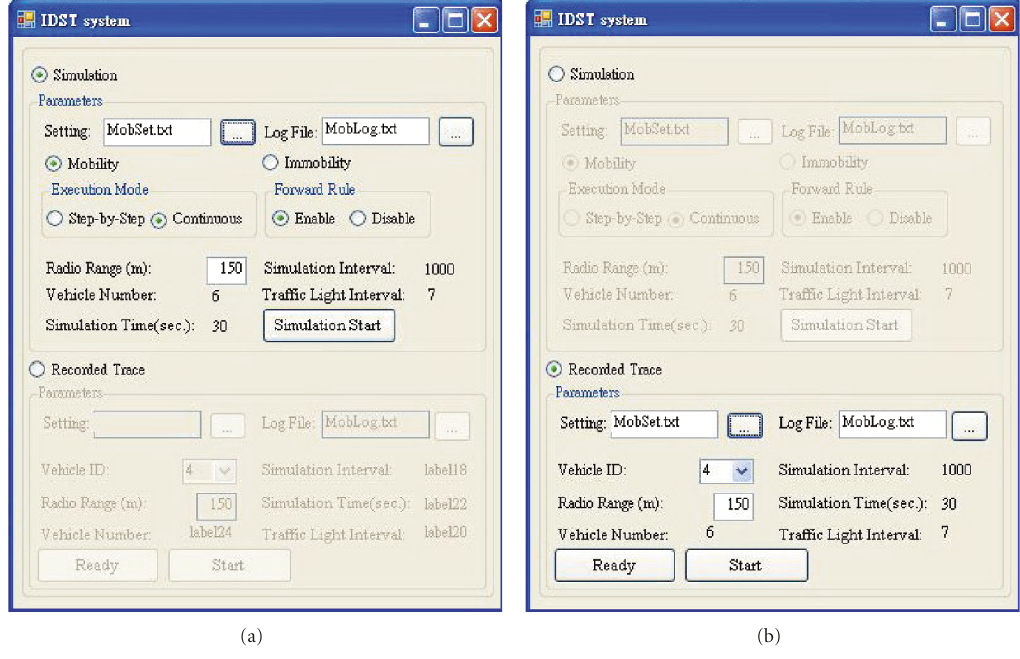
Figure 5: The screen shot of parameter setting in IDST tool.